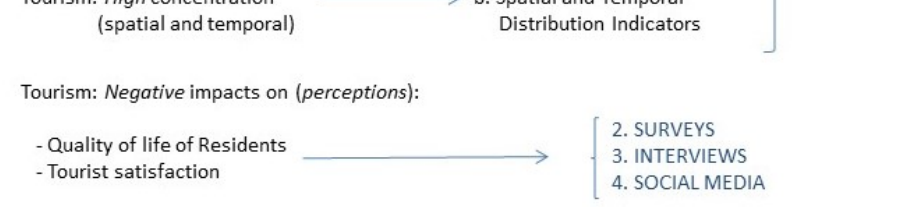
Figure 3. Key elements of overtourism and their measurement tools.